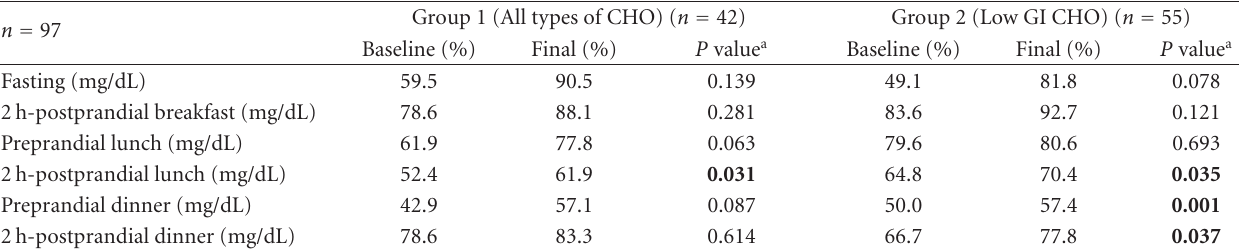
Table 4: Proportion of women who achieved glycemic goals in capillary blood before and after the intervention in both groups. n =